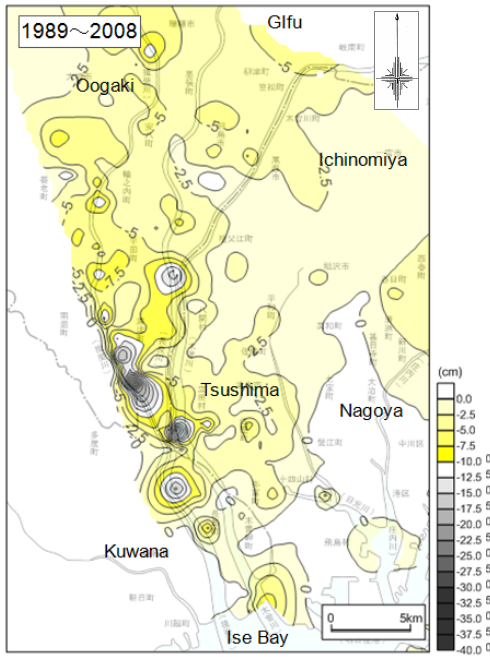
Figure 3. Cumulative land subsidence amount in the Nobi Plain (1989–2008).